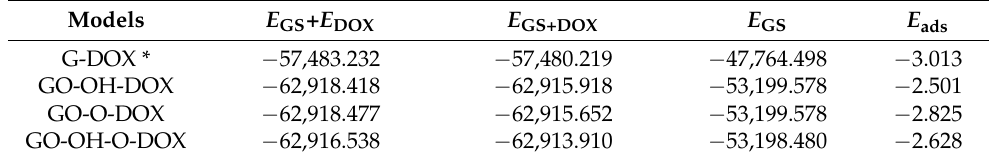
Table 1. Adsorption energy of the stable structure (eV).